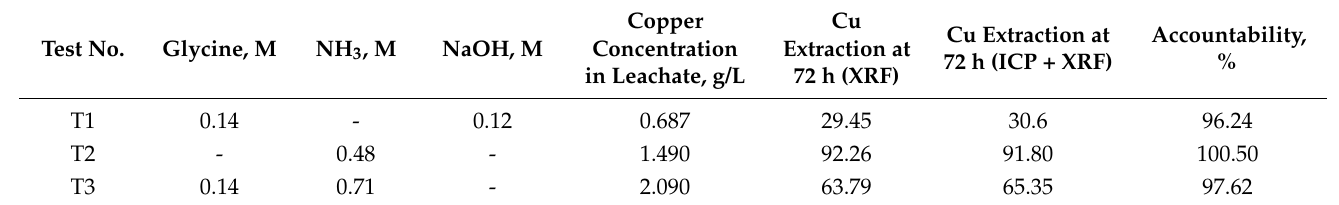
Table 4. Reagent dosages, final Cu concentration and final Cu extractions for different tests: T1 (Gly + NaOH), T2 (ammonia only) and T3 (Gly +